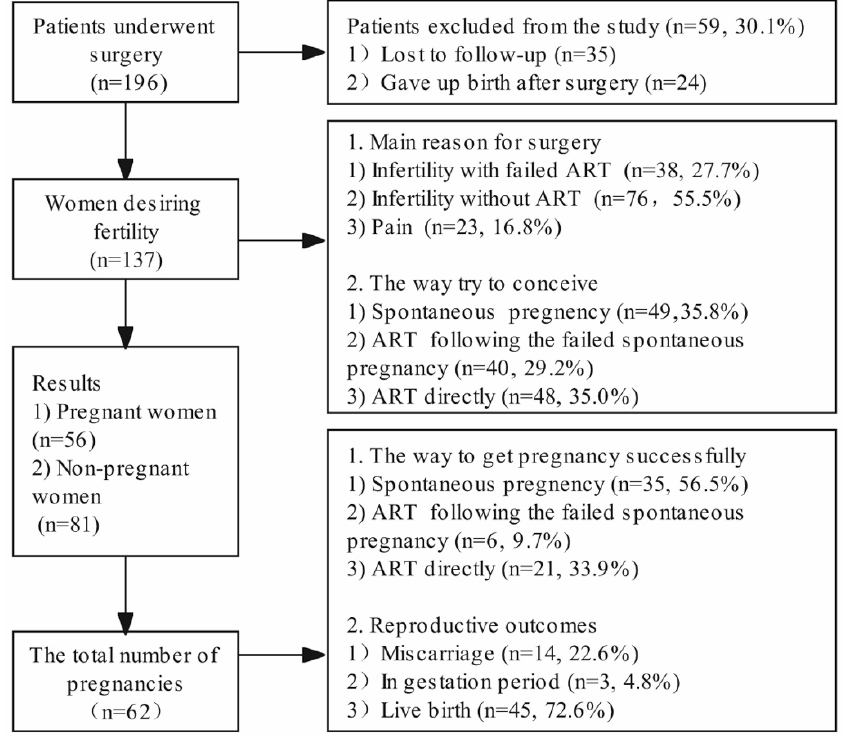
Figure 2. Flow diagram of the clinical data of women who underwent double-flap adenomyomectomy. Table 1. Comparison of baseline characteristics between pregnant and non-pregnant patients ( n =